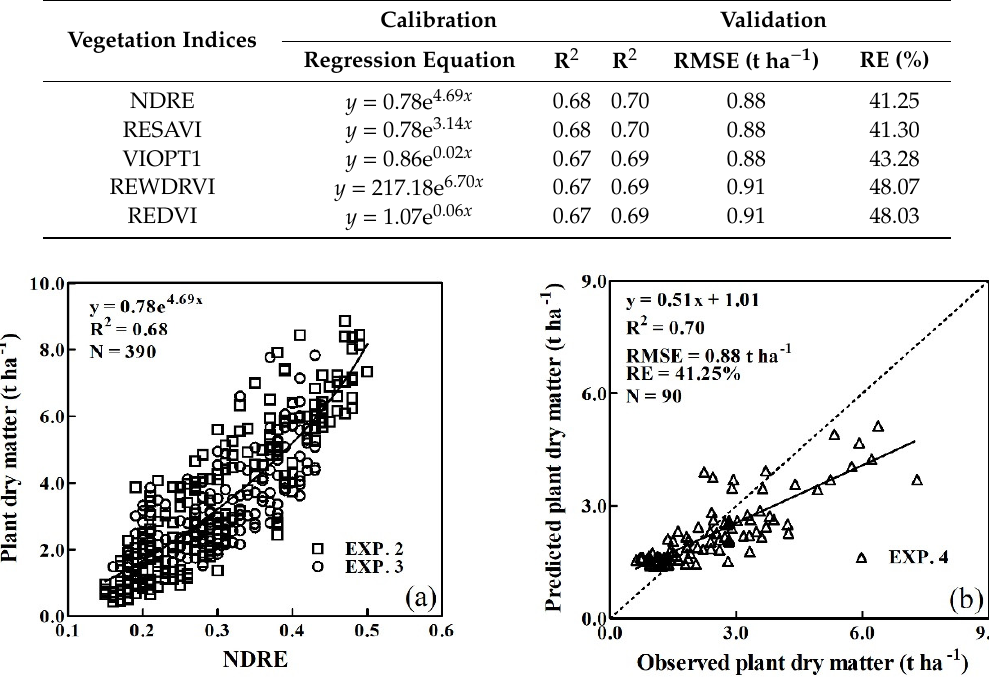
Figure 4. Calibration ( a ) and validation ( b ) results of the relationship between PDM and NDRE across all growth stages.